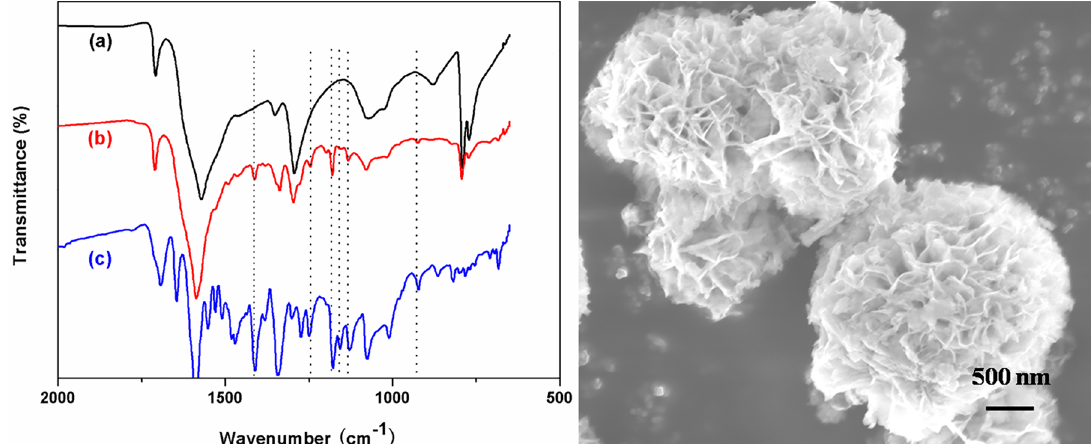
Figure 4. FTIR spectra of the BiOI architectures before (a) and after (b) RhB adsorption and (c) pure RhB (left) and SEM image of RhB-adsorbed BiOI hierarchical structure (right)